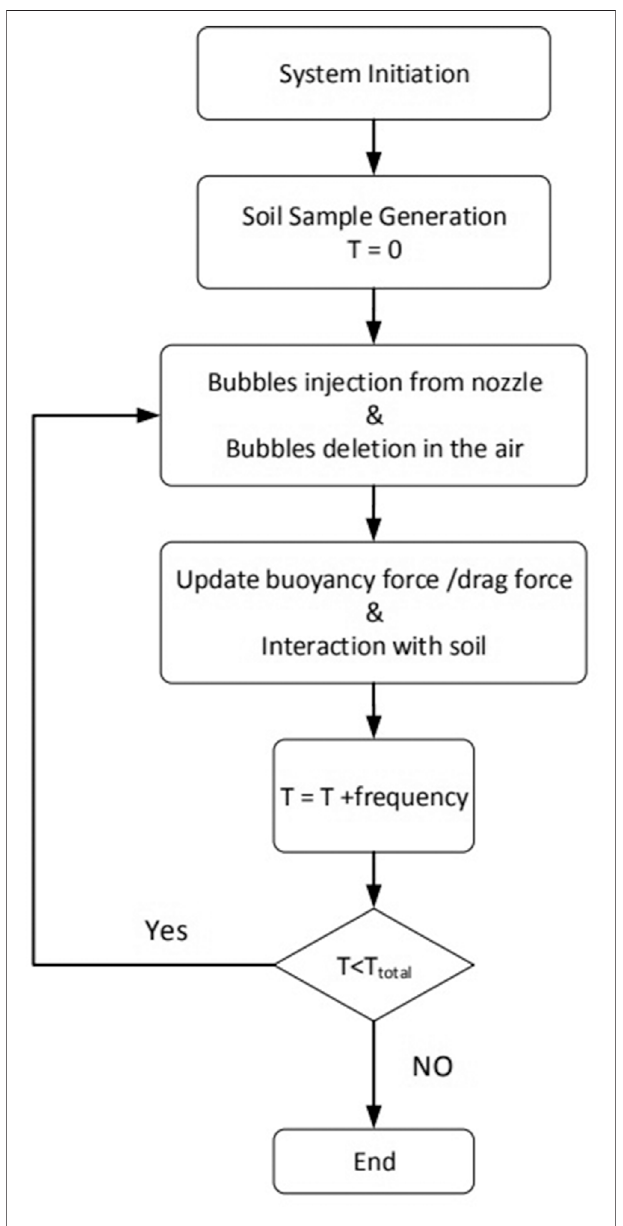
FIGURE 1 | Flow chart of air sparging technology by